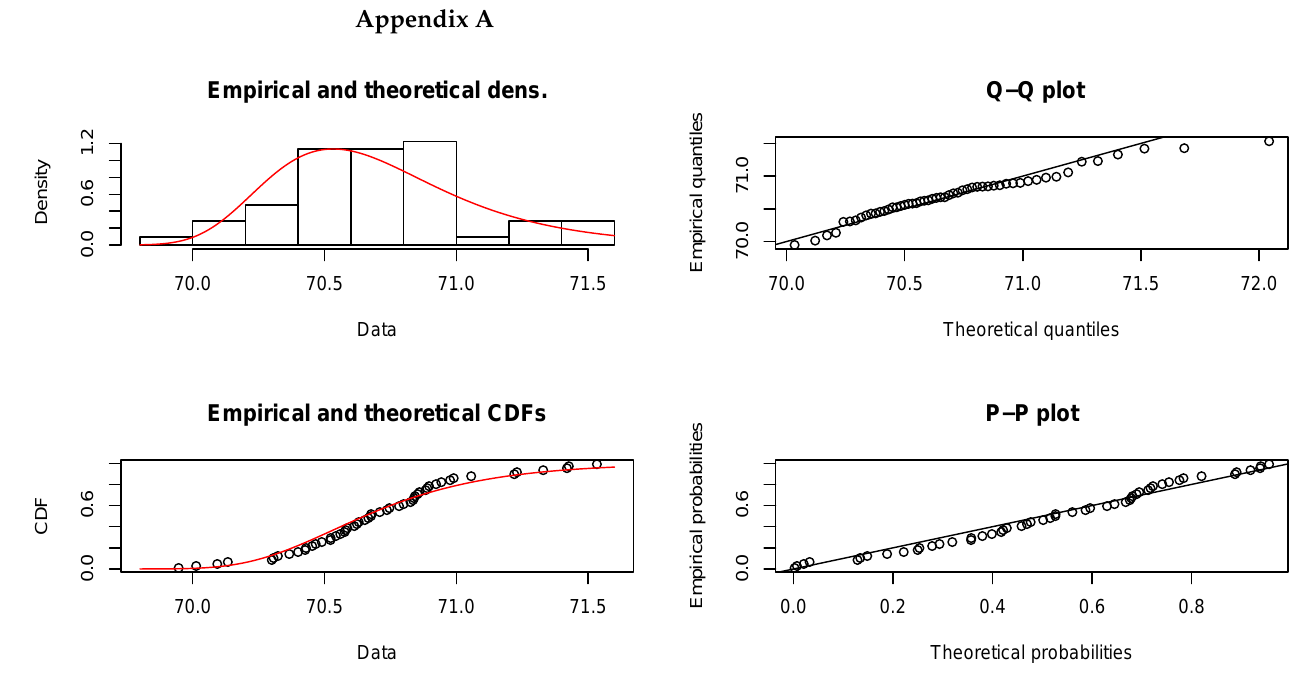
Figure A1. Diagnostic plots to assess fit of Gumbel distribution: males. Empirical and theoretical dens.